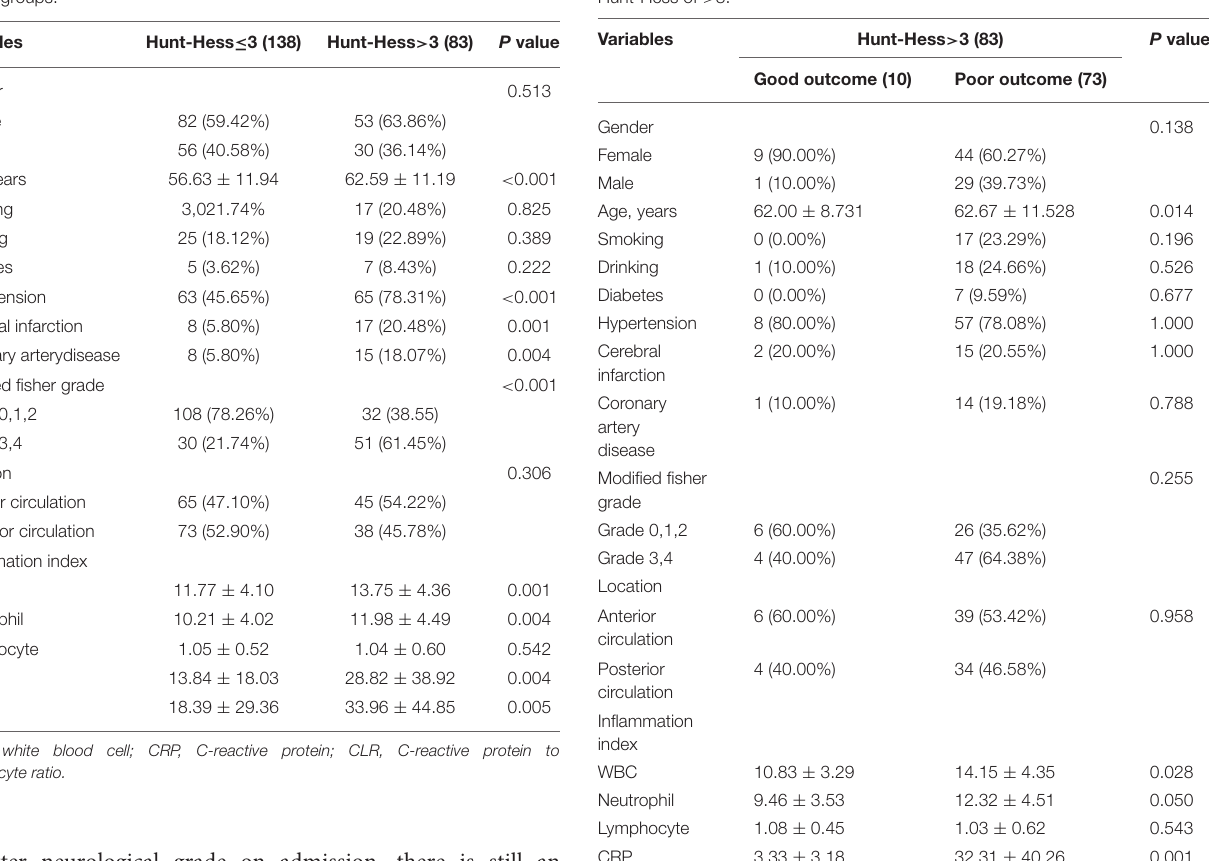
TABLE 4 | Clinical characteristics of clinical prognosis in patients with aSAH with Hunt-Hess of > 3.